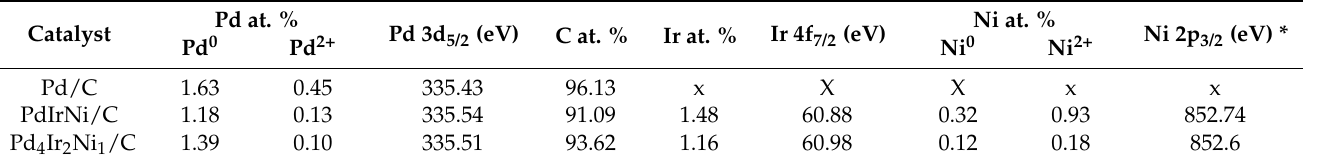
Table 4. X-ray photoelectron spectroscopy (XPS) data of valence state and metal/oxide atomic concentration measurements in Pd/C, Pd 4 Ir 2 Ni 1 /C and